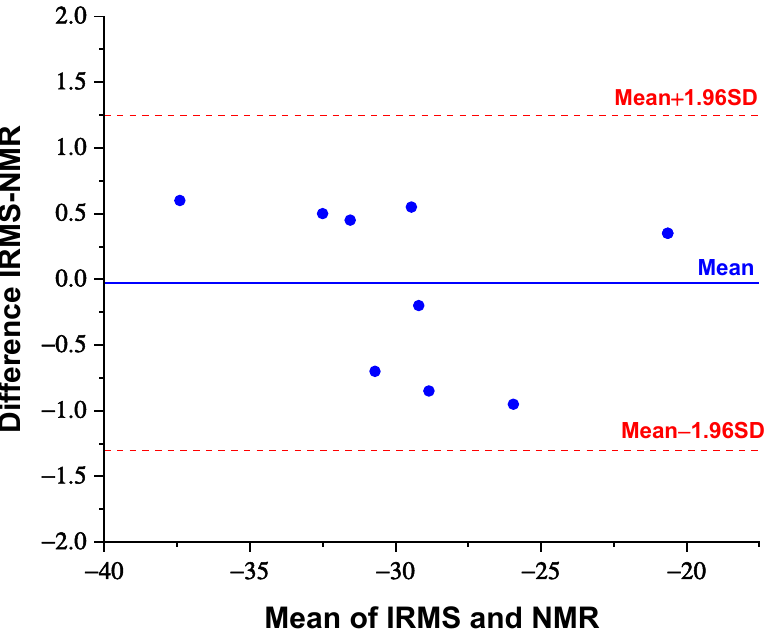
Figure 5. Altman–Bland plot of the difference in δ 13 C values between IRMS and NMR versus the mean of the data pairs (SD: standard deviation).